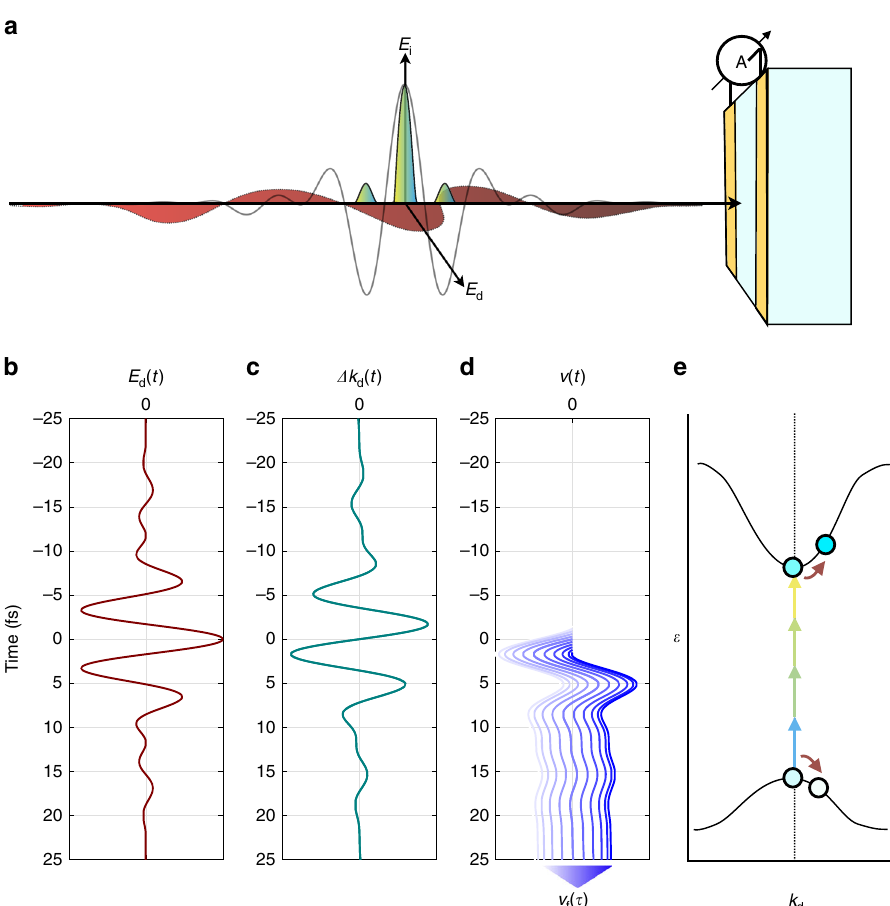
Fig. 1 Field-dependent motion of charge carriers upon interaction with a pair of laser pulses. a The cross-polarized fi elds, E i and E d are incident on a Z-cut quartz sample with gold electrodes attached to the material in the vicinity of the point of incidence of the laser pulses. The strong, nearly single-cycle pulse E i induces a transition from the valence to the conduction band in the material, in the presence of the orthogonally polarized driving fi eld E d ( b ). c In an independent-particle picture, the crystal-momentum offset Δ k d of an injected carrier along the horizontal direction is proportional to the time integral of the fi eld E d . This offset, together with band energies, determines the group velocities of charge carriers ( d ). In a semiclassical picture where photoinjection at time τ creates a wave packet with zero initial velocity, the average velocity at later times is determined by Δ k d ( t ) − Δ k d ( τ ). Thus, the average velocity of the carriers is sensitive to the time τ of the transition, which is controlled experimentally via the relative delay of the two laser fi elds, setting the in-band acceleration of the carriers after the photoinjection event ( e ). The measured dipole in the dielectric is proportional to the average displacement of charge carriers, which is obtained by integrating their average velocity over